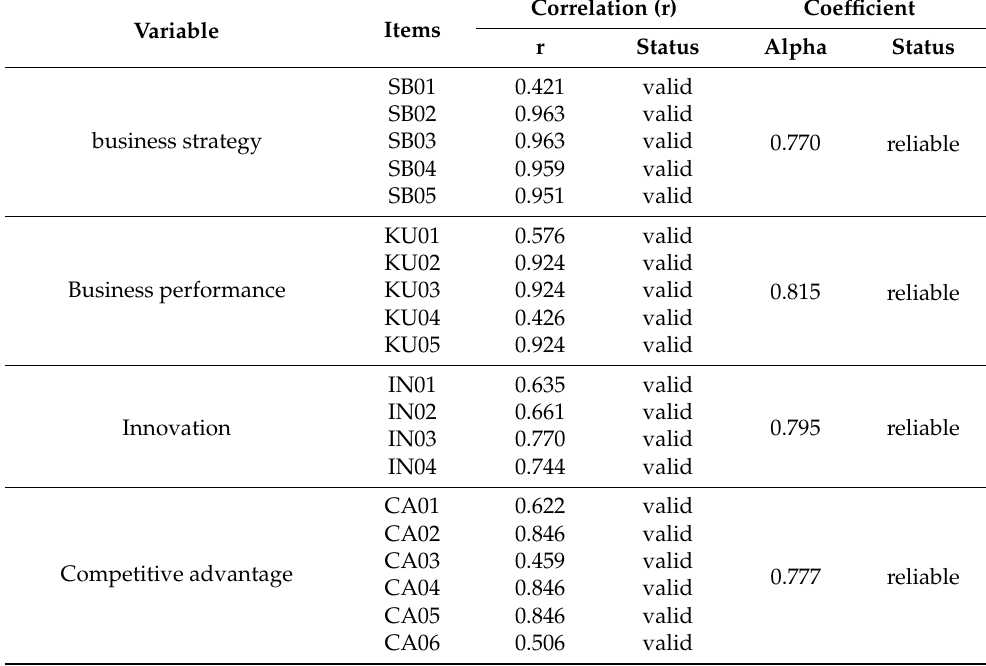
Table 3. Validity and reliability test.